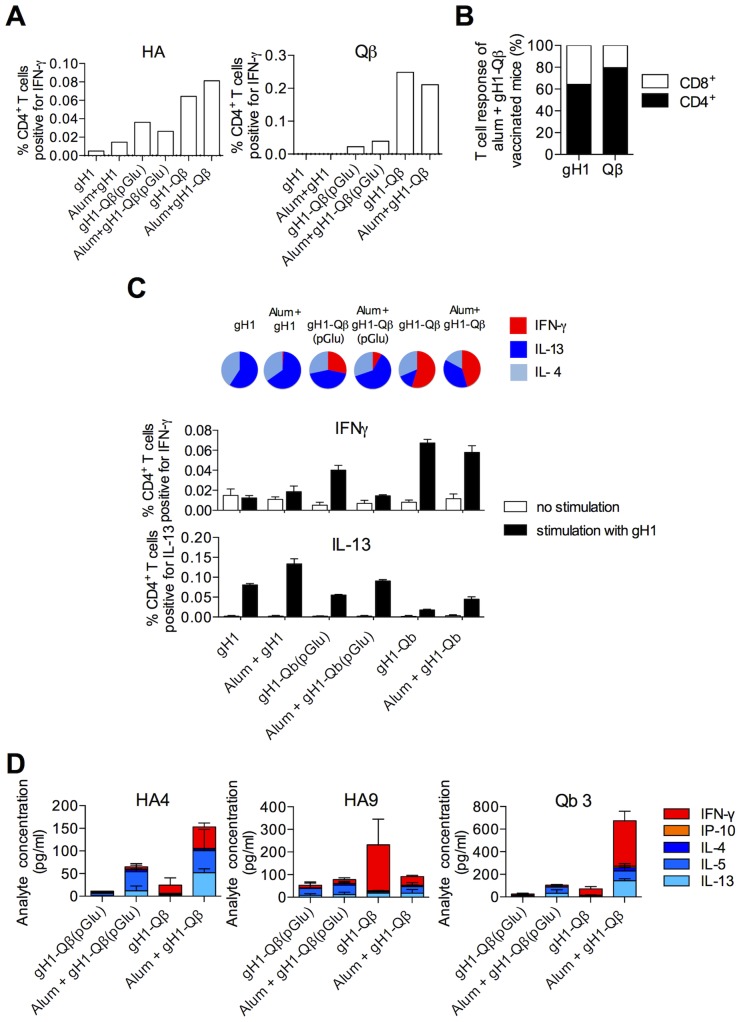
The presence of ssRNA in Qβ VLPs is responsible for an increased Th1 bias in the influenza-specific CD4+ T cell response.Mice were immunized with 1 µg gH1, 10 µg gH1-Qβ or 10 µg gH1-Qβ(pGlu) as indicated, either non-adjuvanted or adjuvanted with alum, and T cell responses measured two weeks post second dose. (A) Frequency of HA and Qβ specific IFNγ-producing CD4+ T cells was determined by intracellular staining after stimulation with peptides from the HA (peptide pools HA 4, HA5, HA6, HA8 & HA9) and Qβ (peptide pools Qβ 2, Qβ 3, Qβ 4 & Qβ 6) regions of the gH1-Qβ vaccine. Each data point is the total response obtained by adding together individual responses measured for each peptide pool. Mouse splenocytes were pooled from at least three mice and data are representative of at least two experiments performed with similar results. Unstimulated samples were subtracted from the peptide-stimulated samples. (B) Plot of the relative proportion of CD4+ and CD8+ contributions to IFNγ+ T cell responses, as obtained in (A), to ex-vivo stimulation of HA and Qβ peptides for mice immunized with 10 µg alum-adjuvanted gH1-Qβ. (C) Histogram showing the frequency of CD4+ T cells, determined by intracellular labeling, that are positive for the indicated cytokine following ex-vivo stimulation with recombinant gH1 or diluent alone. Pie-charts display responses plotted as relative frequency of IFNγ, IL-4 and IL-13 producing CD4+ T cells, with values from unstimulated samples subtracted from the Ag-stimulated sample. Each data point is the mean response of three replicate measurements from splenocytes pooled from at least three mice and is representative of at least two experiments performed with similar results. (D) Total secreted cytokine levels to the indicated HA and Qβ peptide pools. Each data point is the response from splenocytes pooled from at least three mice and is the mean of two independent experiments (error bars represent the range).